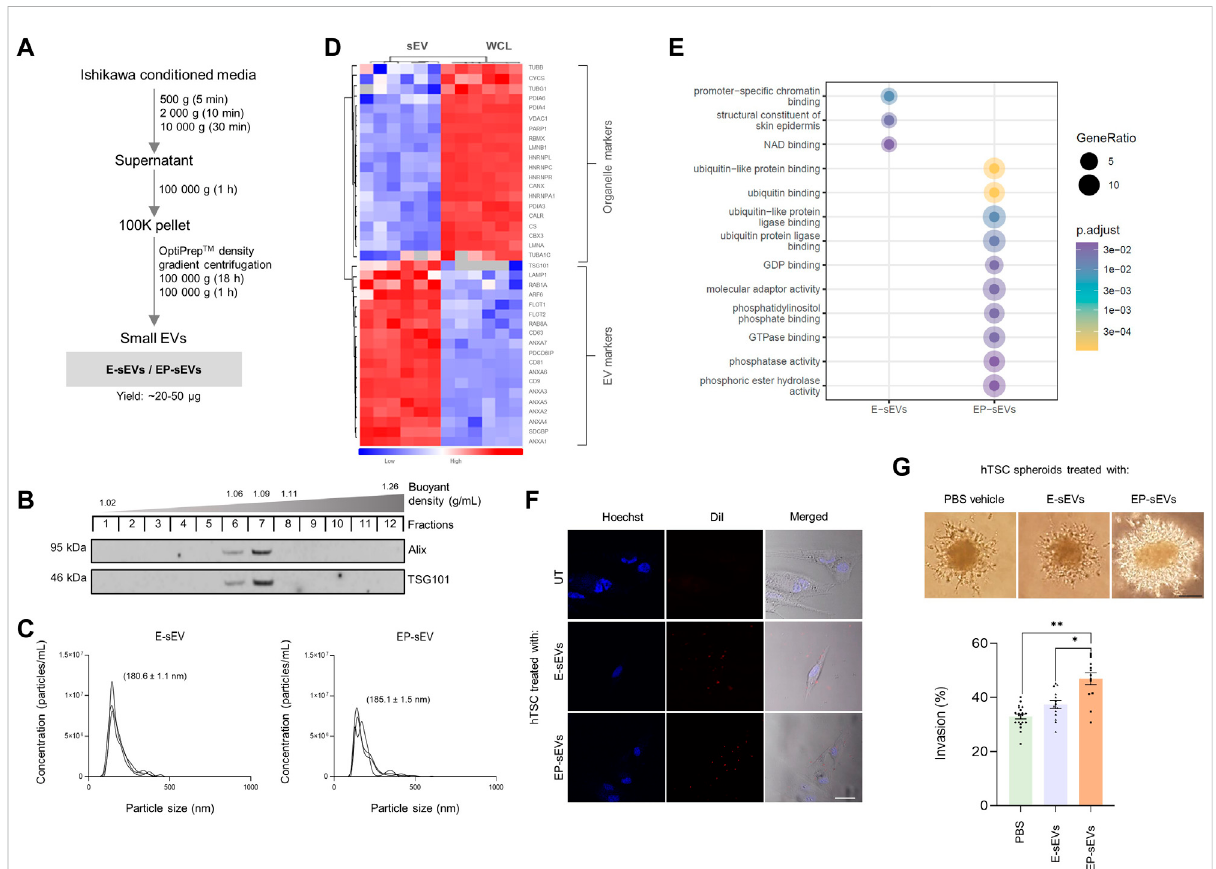
FIGURE 1 Smallextracellularvesiclesfromendometrialcellsrepresenting secretoryphasepromotehumantrophectodermcellinvasion .(A) Experimental work fl ow for isolation of endometrial sEVs from Ishikawa cells using differential ultracentrifugation and buoyant density-based separation (OptiPrep ™ ). Ishikawa cells were primed with estrogen (E) (proliferative phase), and subsequent E and progesterone (P) (EP; secretory phase) to derive E-sEVs and EP-sEVs. (B) Western blot analysis of density-gradient puri fi ed sEVs (fractions 6 – 8, 1.06 – 1.11 g/ml) using anti- Alix and -TSG101; EP-sEVs. (C) Size distribution and concentration (particles/mL) of E- and EP-sEVs by single nanoparticle analysis ( n = 3). (D) . Quantitative mass spectrometry proteome analysis of Ishikawa cell (WCL; combined E/EP-priming) and sEVs (combined E/EP priming), n = 6. Hierarchical clusteringofproteinexpressionofEV(sEV/exosome)markerproteinsandcellorganellemarkers(i.e.,nucleus,mitochondria,endoplasmicreticulum and cytoskeleton). Scale represents normalized label-free quantitation intensity ( p < 0.05, Student ’ s T. test). (E) Gene Ontology enrichment analysis (DAVID) of EP-sEVs vs. E-sEVs (signi fi cantly enriched or uniquely identi fi ed). (F) Uptake of E-/EP-sEVs to hTSCs using live fl uorescence and bright- fi eldmicroscopicanalysis(100 μ g/ml, 2 h).sEVs stained with lipophilic tracer DiI (red),nuclei stained with Hoechst(blue). Scalebar, 20 µm. (G) hTSC spheroidMatrigel ™ invasionassay;toppanel,phase-contrastmicroscopyimagesofhTSCspheroidspre-treatedwithE-/EP-sEVsorPBS(untreated; UT) and overlaid on Matrigel ™ matrix to invade (48 h), scale bar, 100 μ m; bottom panel, mean invasive outgrowth ±SEM ( n = 13 – 20 replicates with four invasive fronts measured per spheroid, * p ≤ .001, ** p ≤